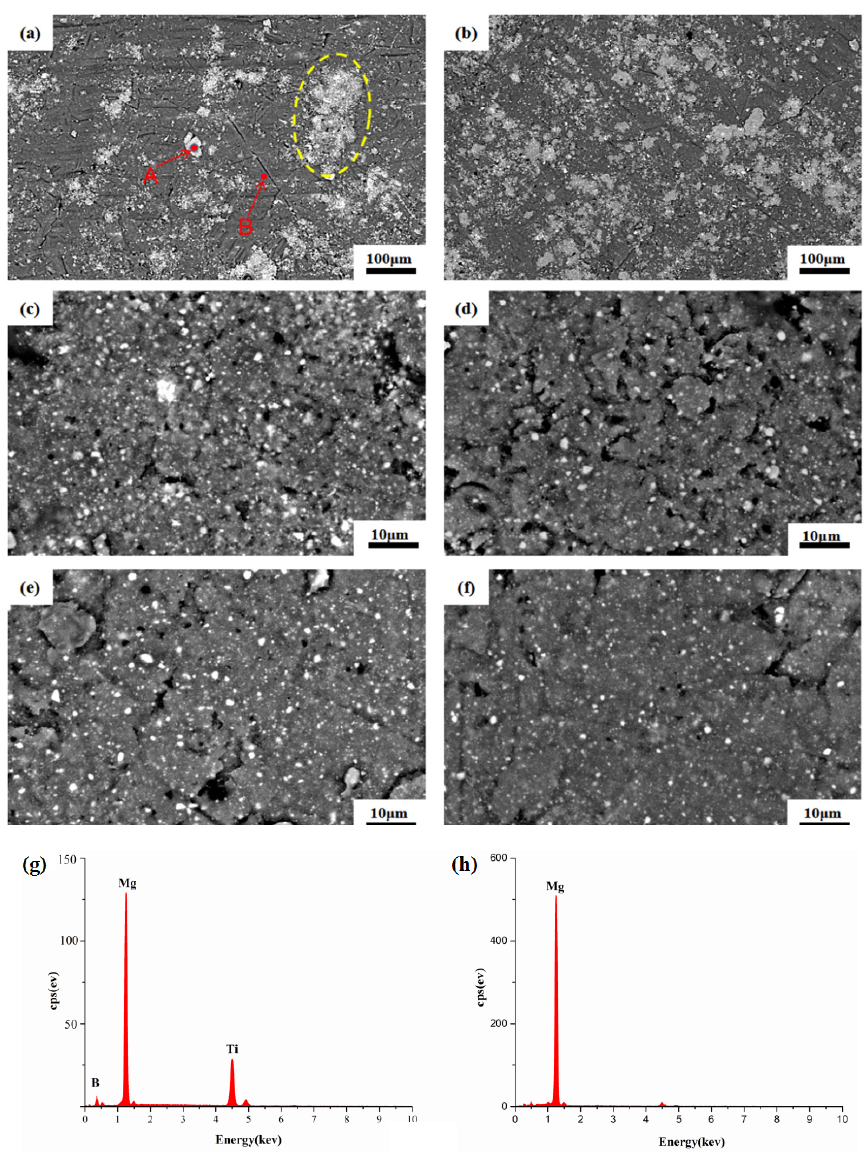
Figure 5. The BSE images of composite powders with 5 wt % TiB 2 addition after milling for different times, and the corresponding EDS results: ( a ) 10 h, ( b ) 30 h, ( c ) 50 h, ( d ) 70 h,( e ) 90 h, ( f ) 110 h, ( g ) EDS results of point A, ( h ) EDS results of point B.